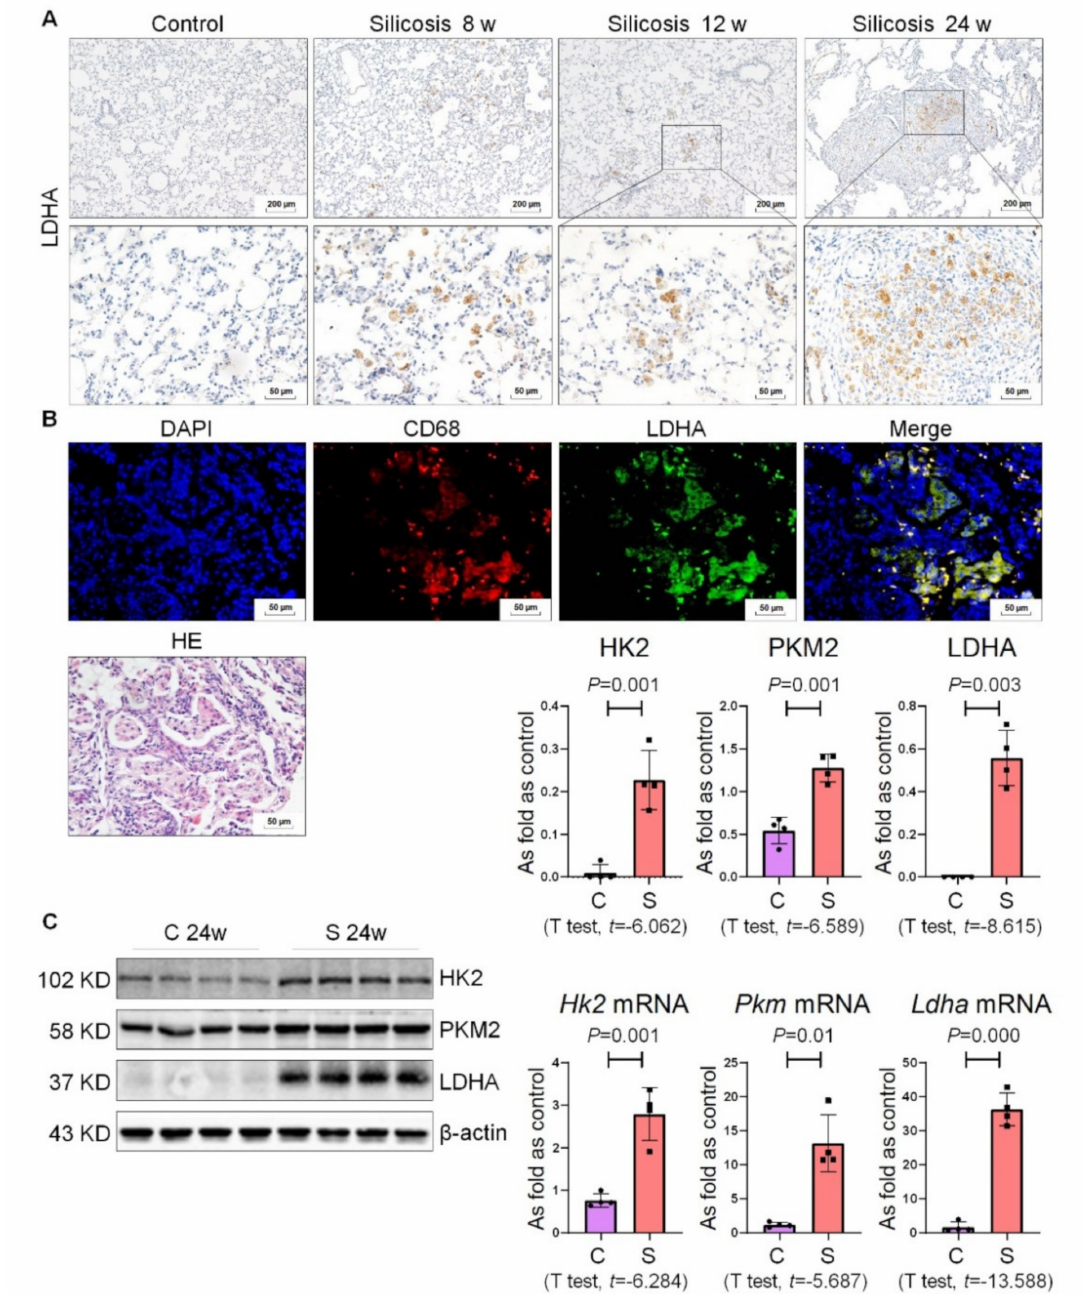
Figure 2. High expression of glycolysis in rats exposed to silica. ( A ) Positive expression of LDHA in silicotic rats observed by IHC staining, bars = 200 µ m or 50 µ m. ( B ) The co-expression of CD68 and LDHA in silicotic rats was measured by IF staining, bar = 50 µ m. ( C ) Protein and mRNA expression levels of HK2, PKM2, and LDHA in silicotic rats measured by Western blotting and qRT-PCR. Data are presented as the mean ± SD. n = 4 per group. C: control 24 w; S: silicosis 24